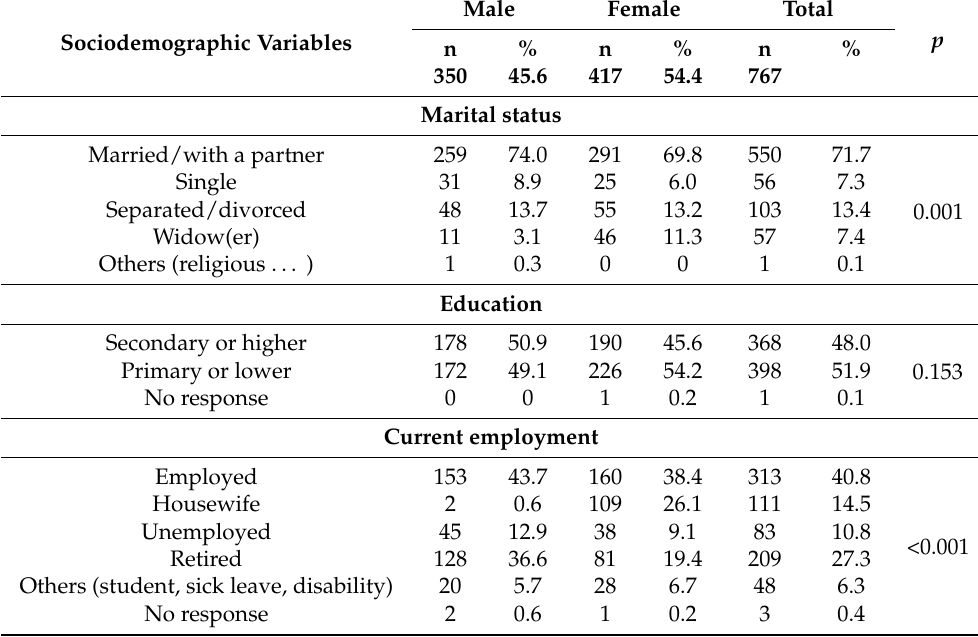
Table 1. Sociodemographic characteristics of the